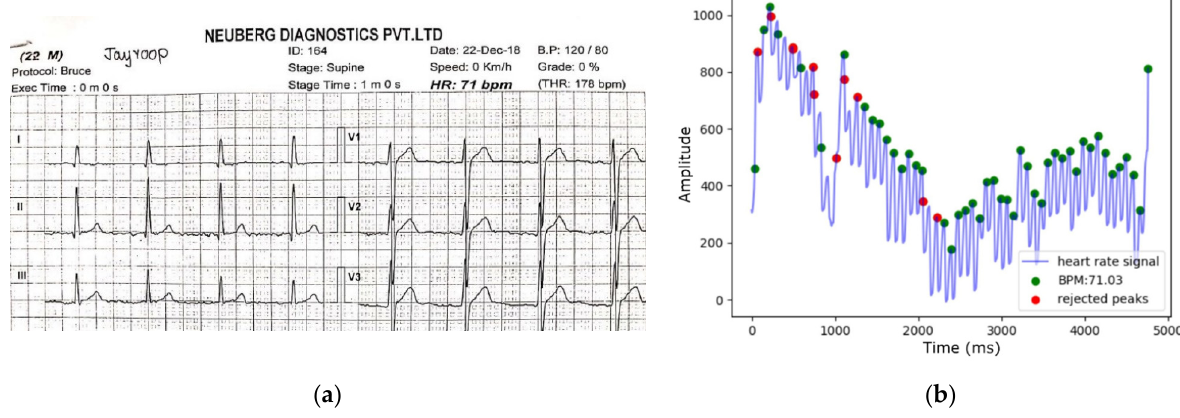
Figure 8. Measured ECG vs. estimated PPG BPM comparison. ( a ) Reference ECG-measured BPM; ( b ) PPG-derived BPM by peak detection algorithm.